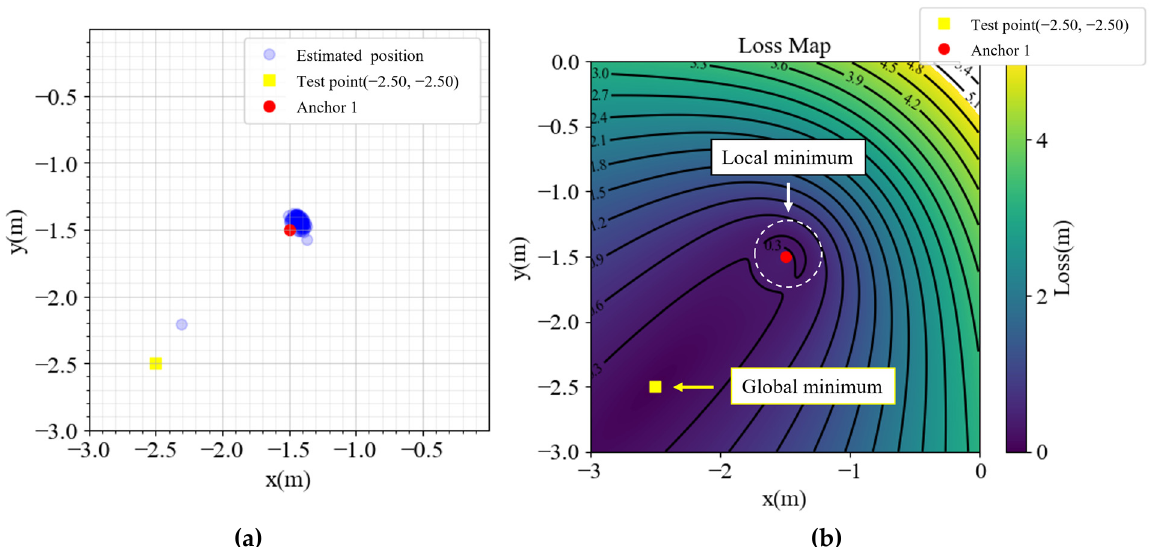
Figure 6. ( a ) Estimated positions and ( b ) loss map of point ( − 2.5, − 2.5).